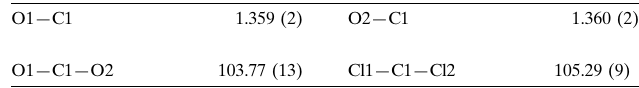
Selected geometric parameters (A˚ , (cid:1) ).